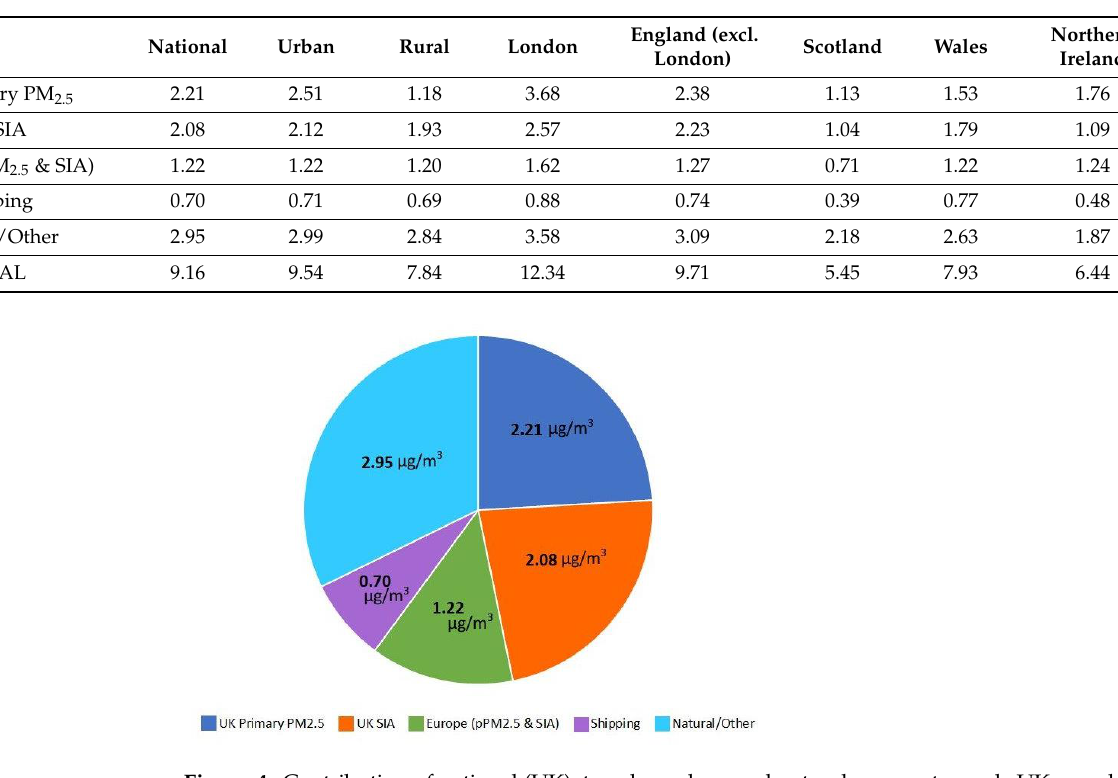
Table 1. Breakdown of contributions to national and regional PM 2.5 Population-Weighted Mean Concentrations (PWMC) for the 2018 base year– µ g/m 3 .